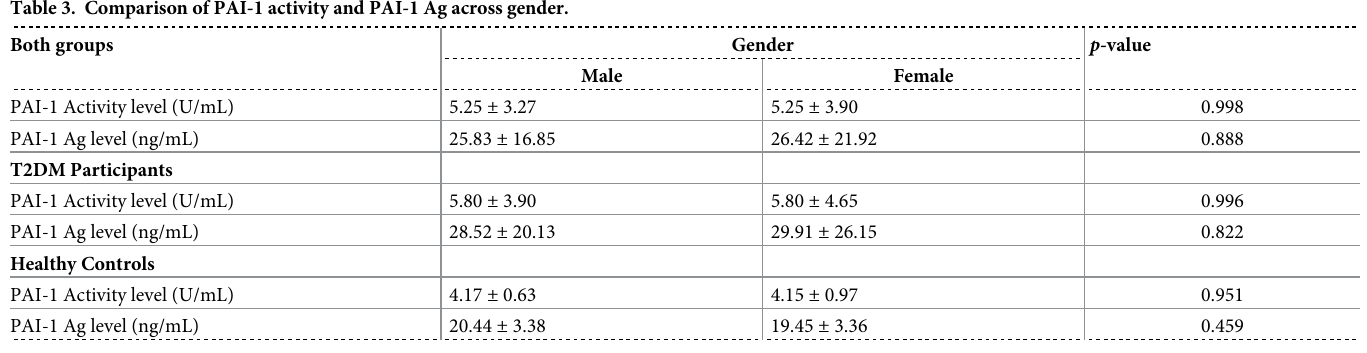
Table 3. Comparison of PAI-1 activity and PAI-1 Ag across gender. Both groups